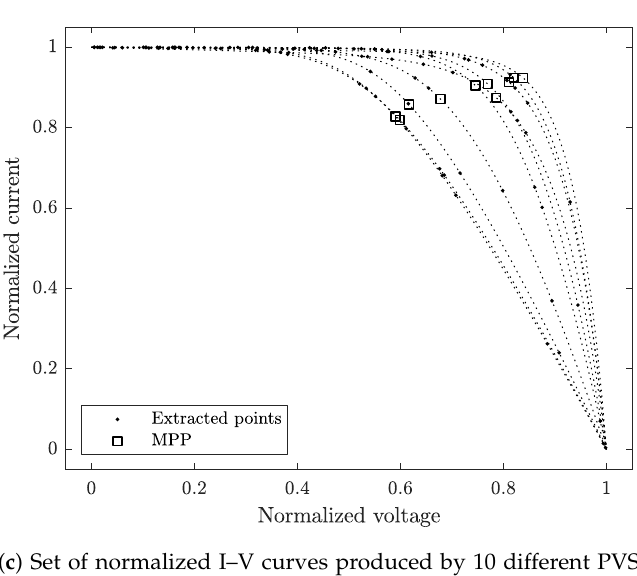
Figure 5. Different characteristics presented in the training